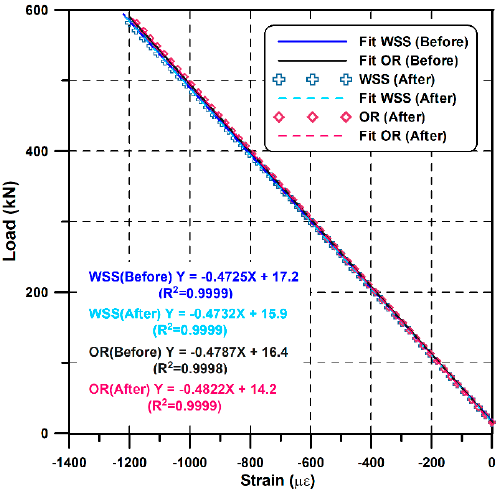
Figure 11. Comparison between the test before and after the FRP